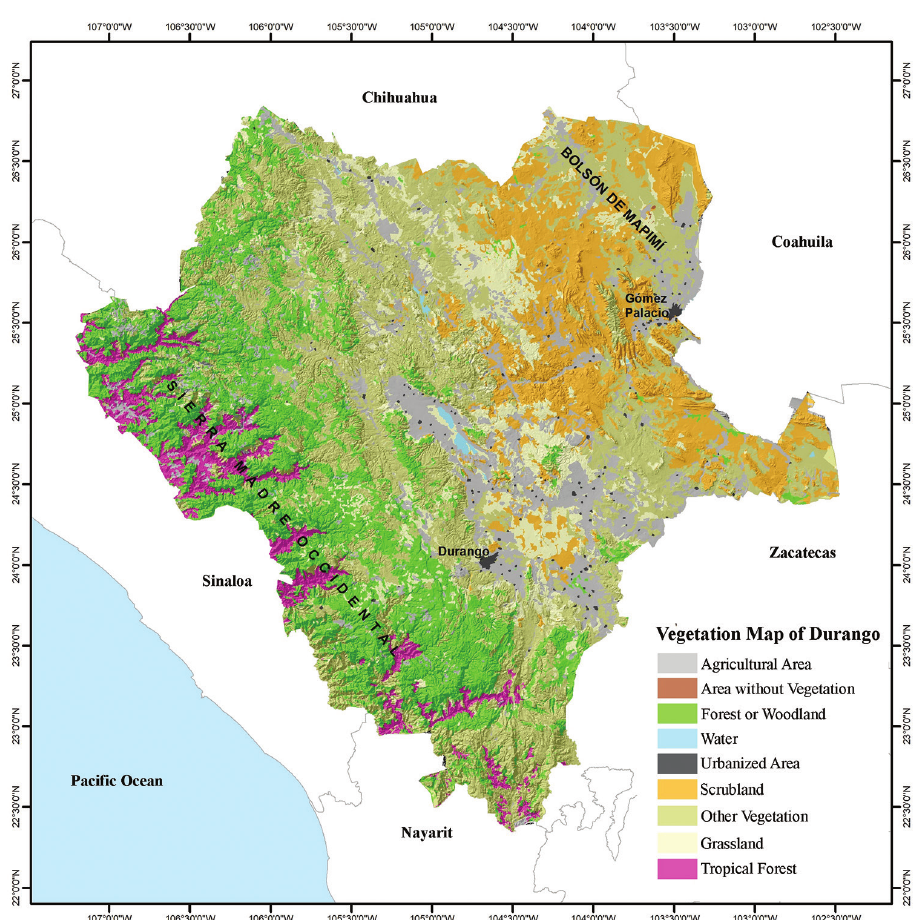
Figure 4. Vegetation map of the state of Durango, Mexico (modified from Dirección General de Geografía – INEGI